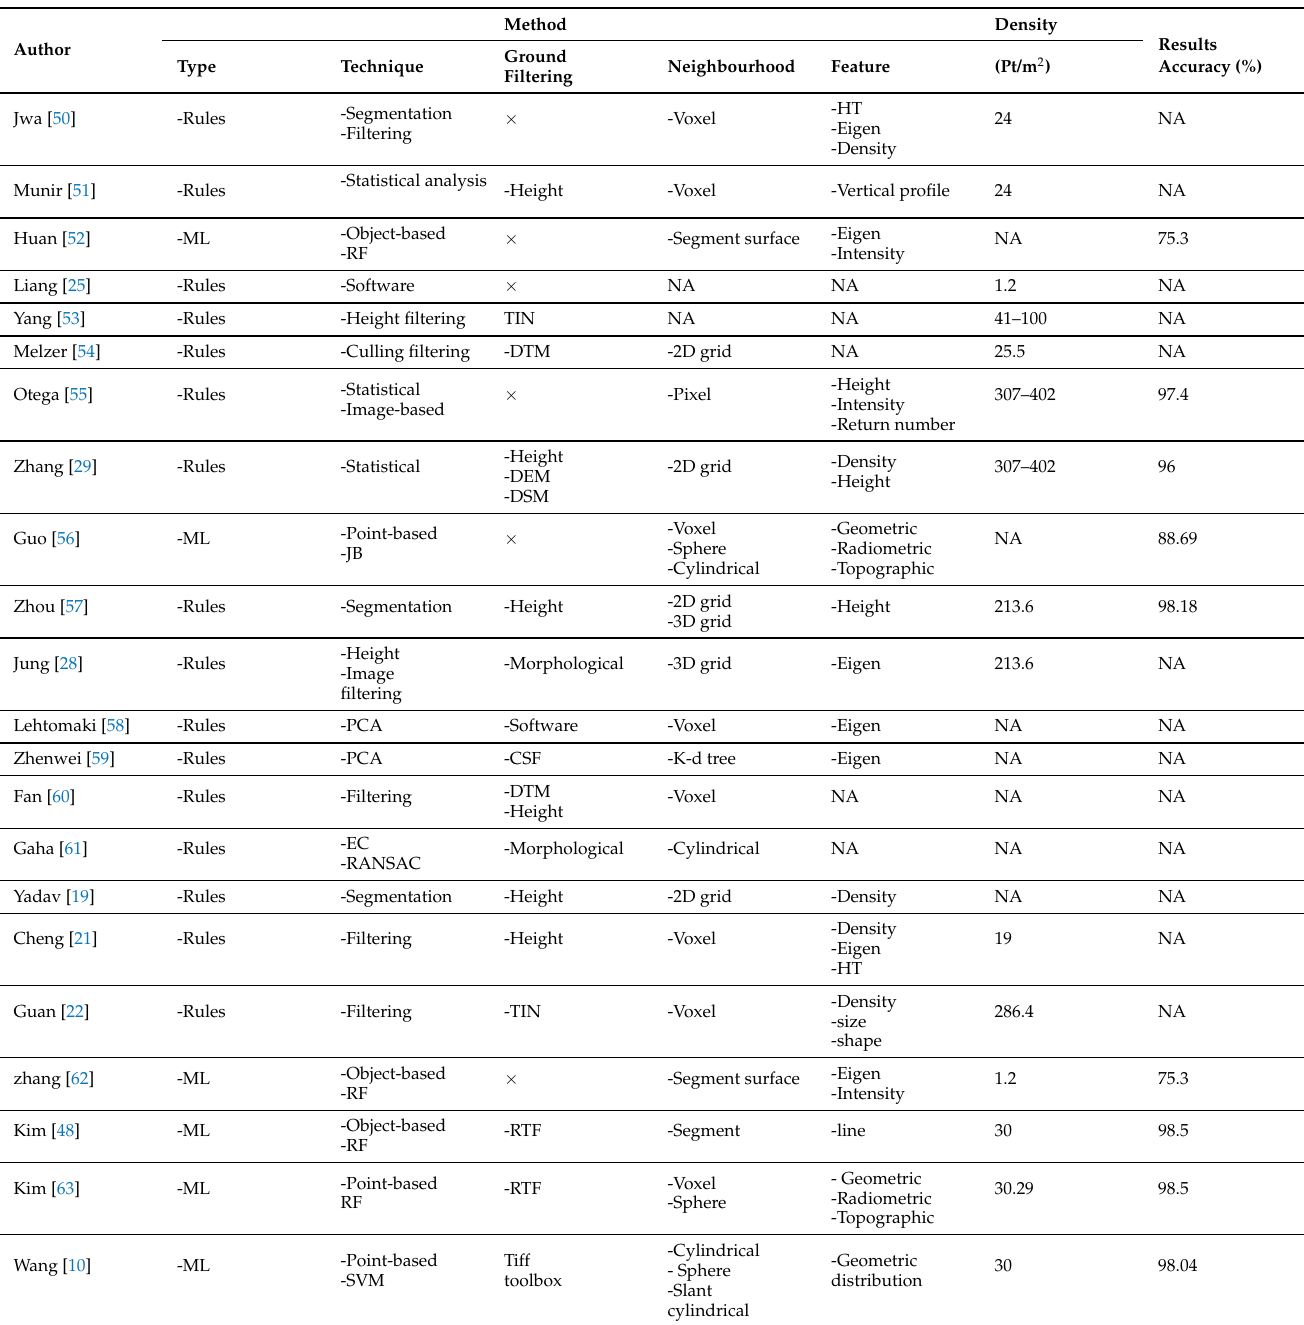
Table 2. Power line scene classification. PCA—Principal component analysis; ML—Machine